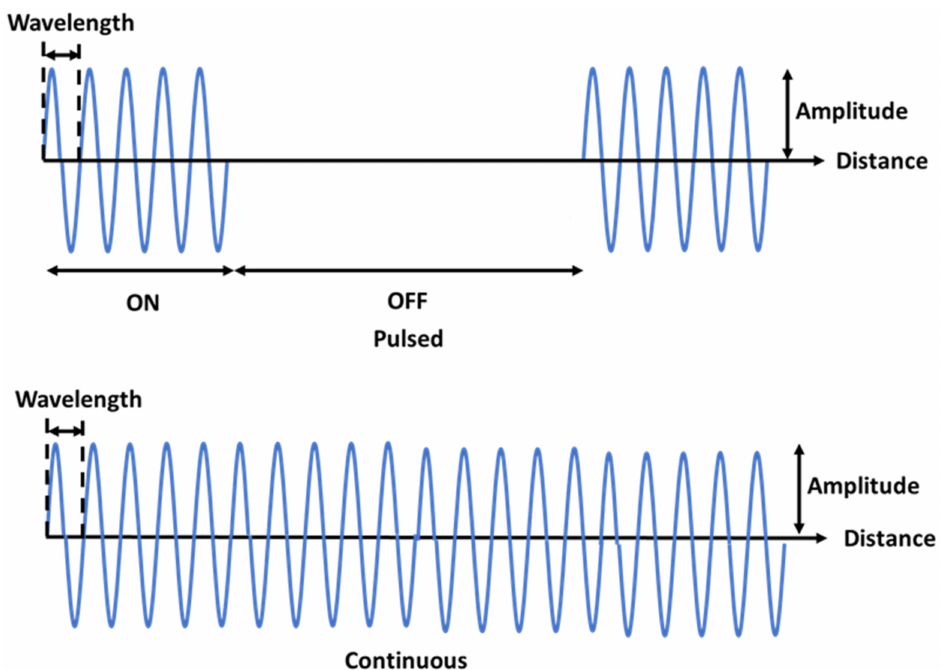
Figure 1. Illustration of the fundamental difference between pulsed and continuous ultrasound waveforms. Top: pulsed US waveform showing ON/OFF cycles. Bottom: a continuous US waveform is a continuous wave with no ON/OFF